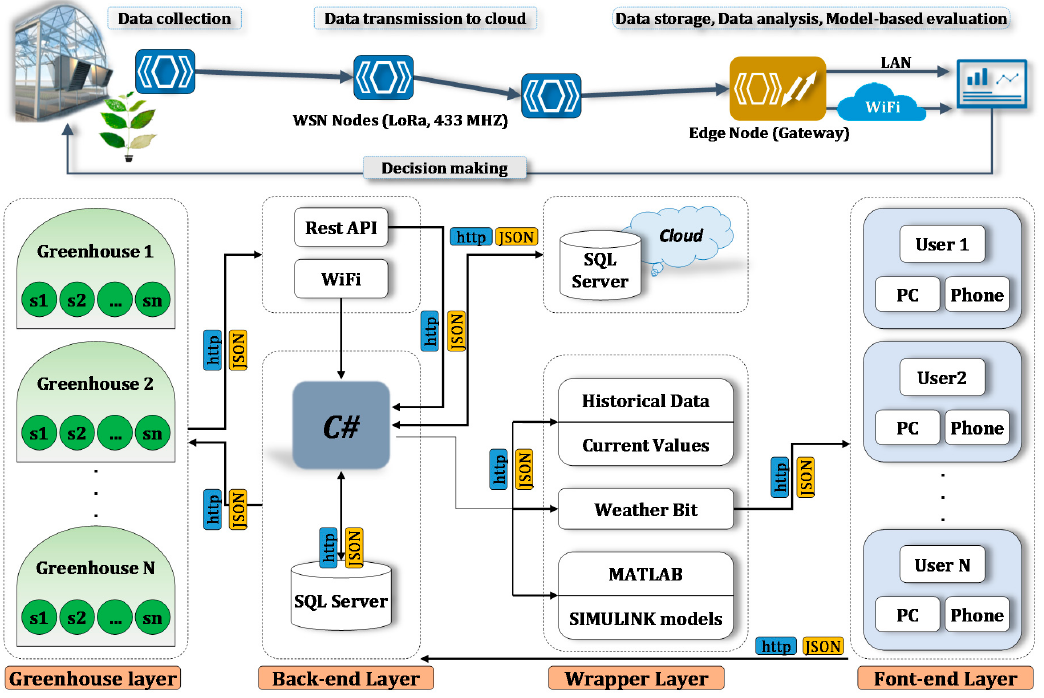
Figure 3. Schematic view of the modular network connectivity solution used for the data collection as described by References [13] and [16] . Picture is the courtesy of Adaptive AgroTech Consultancy International.